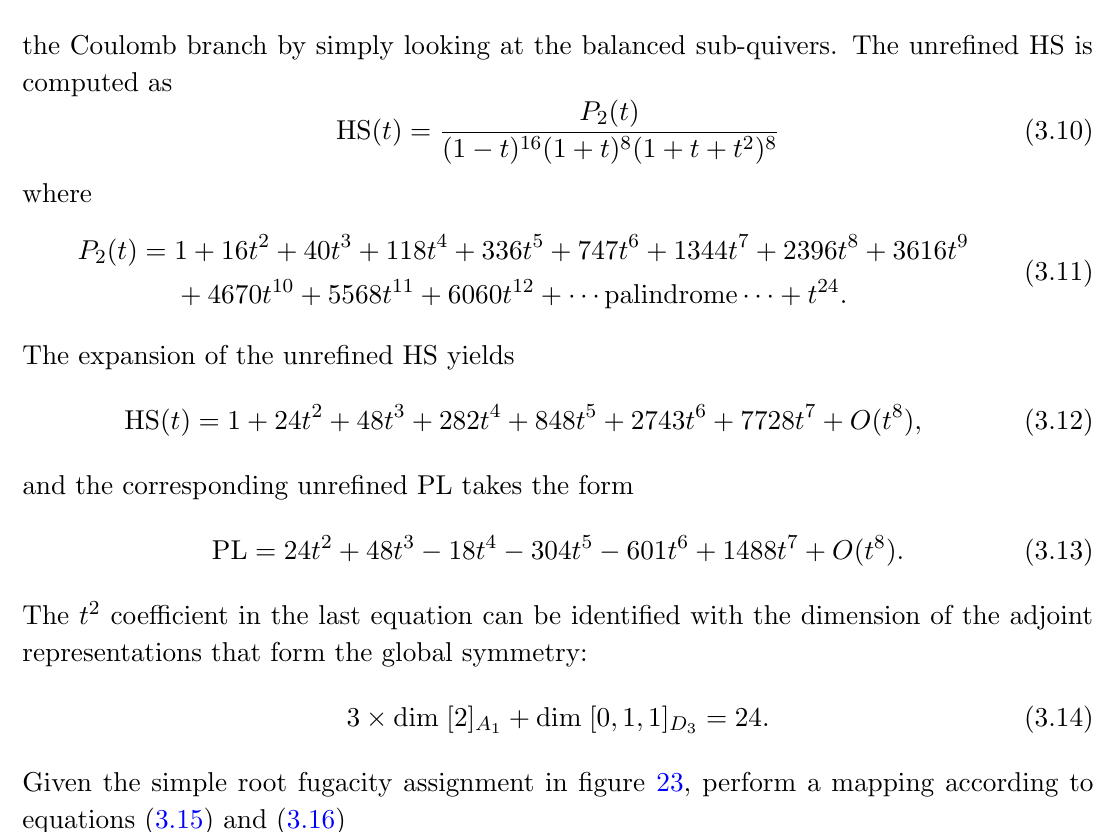
(3), P (2) g quiver with simple root [1 3 ] [1 2 ]